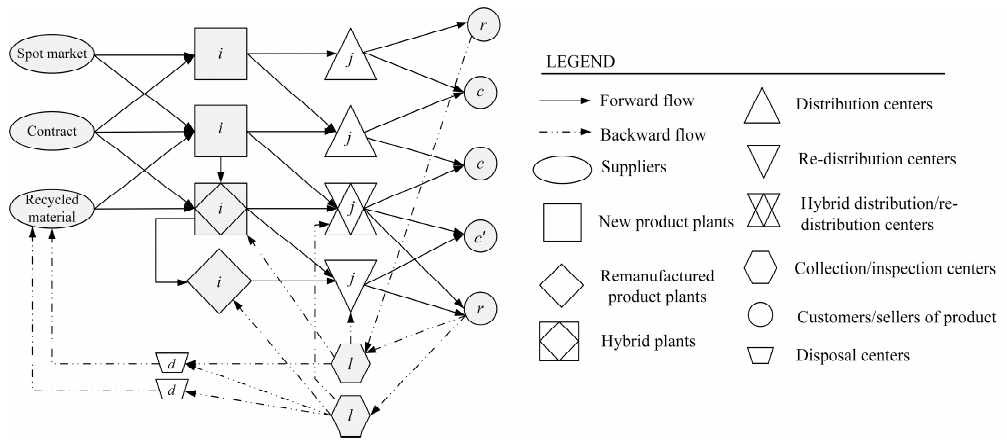
Figure 1. The proposed integrated forward/reverse logistic network model, consisting of suppliers, manufacturers, distribution centers, collection/inspection centers and disposal centers.